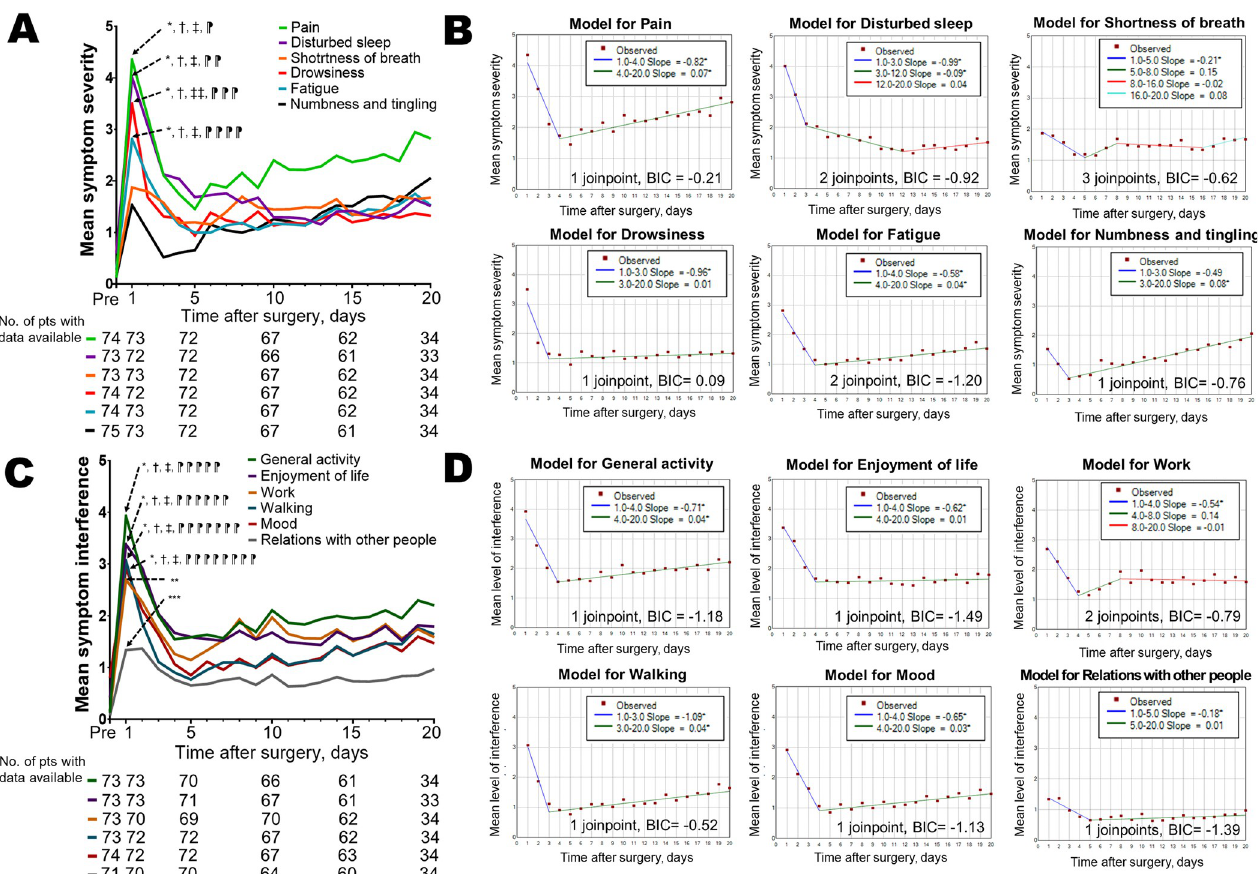
Fig 2. Symptom severity/interference trajectories and the models using the joinpoint regression analysis. A: The symptom severity of pain, disturbed sleep, drowsiness, and fatigue was significantly higher on day 1 than on day 5, day 10, day 15 and day 20 (pain, P < 0.0001, P < 0.0001, P < 0.0001, and P = 0.017; disturbed sleep, P < 0.0001 in all comparisons; fatigue, P < 0.0001, P < 0.0001, P = 0.0002, and P = 0.047; drowsiness, P < 0.0001, P < 0.0001, P < 0.0001, and P = 0.0004). However, the symptom severity of shortness of breath and that of numbness and tingling on day 1 showed no significant difference compared to that on day 5, day 10, day 15 and day 20 (shortness of breath, P = 0.18, P = 0.74, P = 0.41, and P > 0.99; numbness and tingling, P = 0.19, P = 0.82, P = 0.94, and P = 0.20). B: Joinpoint analysis revealed that pain, fatigue, and numbness and tingling showed a rebound in the trajectories. C: The interference level of general activity, enjoyment of life, walking and mood was higher on day 1 than on day 5, day 10, day 15, and day 20 (general activity, P < 0.0001, P < 0.0001, P < 0.0001, and P = 0.0003; enjoyment of life, P = 0.0001, P < 0.0001, P < 0.0001, and P = 0.011; walking, P < 0.0001, P < 0.0001, P < 0.0001, and P = 0.0016; mood, P < 0.0001, P < 0.0001, P = 0.0001, and P = 0.016. The symptom interference of work and relationship with other people on day 1 was higher than that on day 5, but showed no significant difference compared to that on day 10, day 15 and day 20 (work, P = 0.0072, P = 0.20, P = 0.056, and P = 0.33; relationship with other people, P = 0.012, P = 0.11, P = 0.053, and P = 0.48). D: Symptom severity trajectories of general activity, walking, and mood showed a rebound